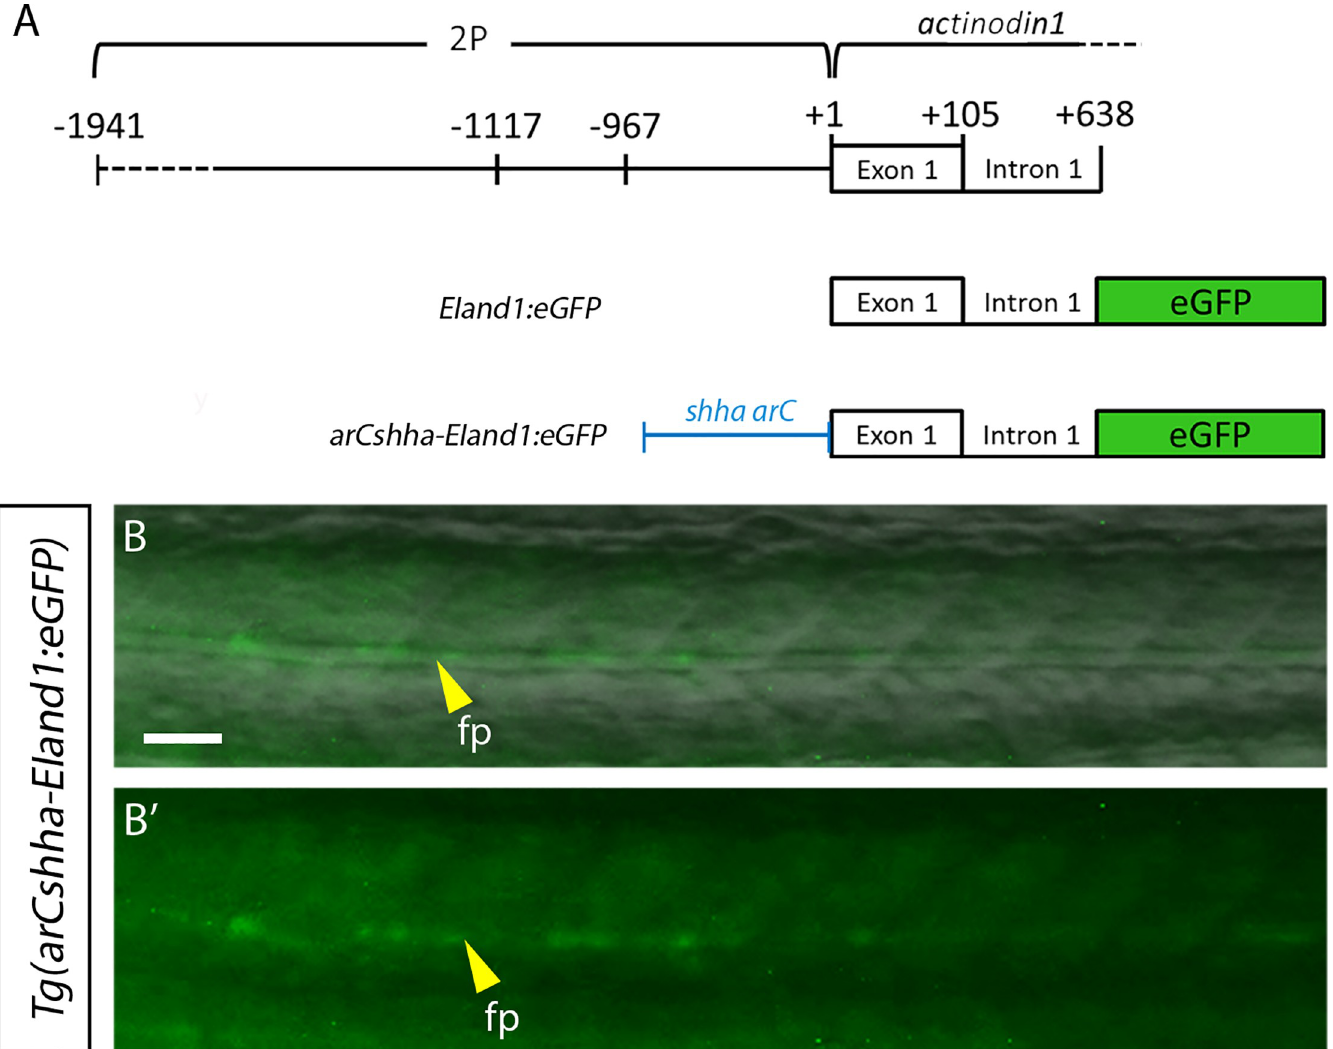
Fig 5. EI contains an alternative promoter. (A) Schematic representation of construct. (B-B’) 1dpf Tg(arCshha-EIand1 : eGFP) F1 generation embryos showing eGFP expression in the floor plate cells (n = 15 fish, 1 line). (B) Merge with bright field image. (B’) Fluorescent image only. fp: floor plate. Scale bar: B-B’ = 25 μ